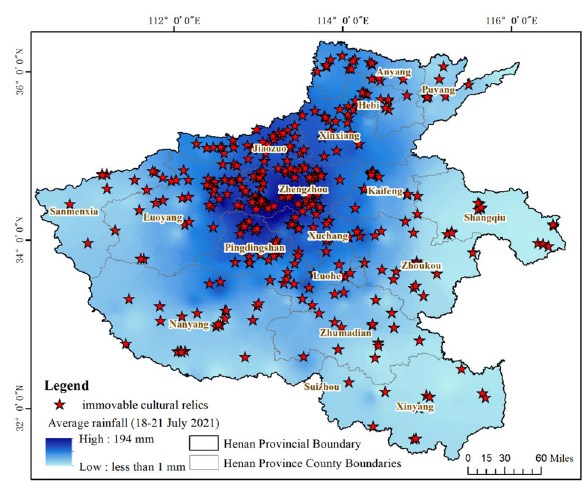
Fig. 1 Distribution of storm rainfall levels in Henan Province 18–21 July 2021, and location of the national protection-level immovable cultural relics in the province